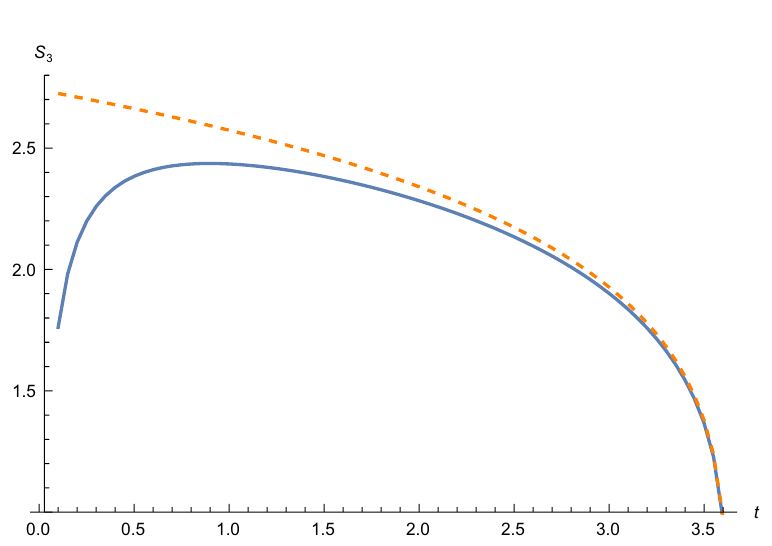
Figure 5 . Plot of the third Rényi entropy S 3 in (4.5) as a function of t = g s K . We set ξ = 18 , β = 4 , g s = 1 / 100 in this figure. The solid blue curve is S 3 in (4.5). The dashed orange curve represents e S 3 in